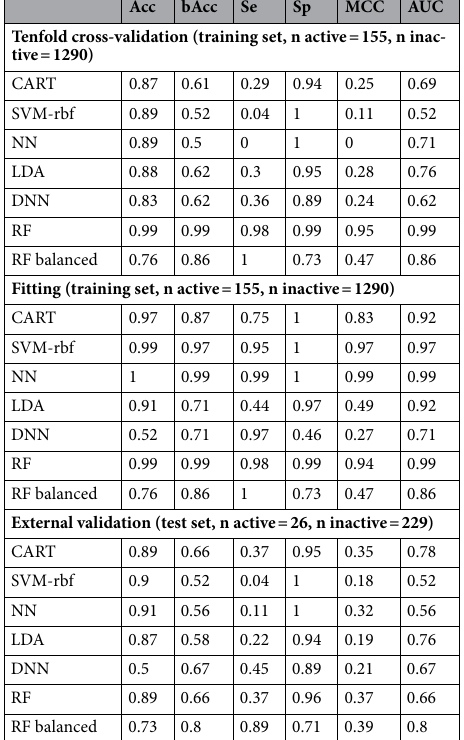
Table 3. Performance of QSAR classification models for P4up activity in H295R assay. Acc accuracy, bAcc balanced accuracy, Sp specificity, Se sensitivity, AUC Area Under the Receiver Operating Characteristic Curve, MCC Matthew Coefficient Correlation, see “Material and methods”.